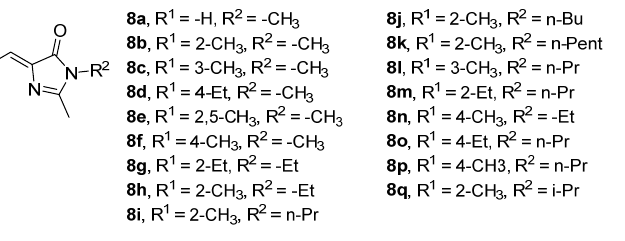
Figure 8. GFPc analogues demonstrating an increased emission intensity in the presence of a deep cavity cavitand [22].